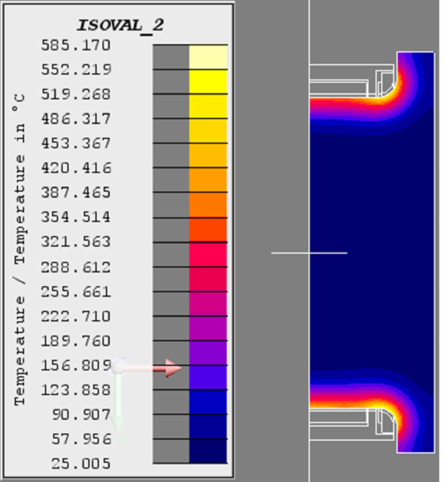
Figure 5. Temperature field of the crankshaft (T = 6 s).